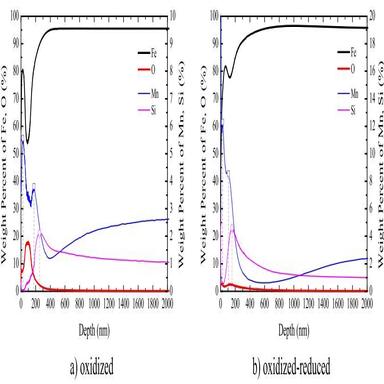
Fe, O, Mn, Si depth profiles of the oxidized and oxidized-reduced sample. a) oxidized, b) oxidized-reduced.